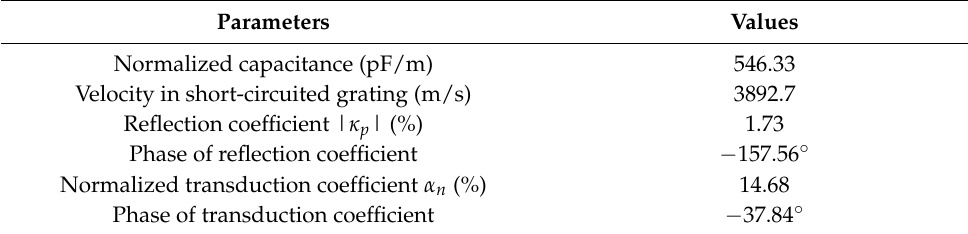
Table 2. COM parameters for EWC SPUDT on 128 ◦ YX LiNbO 3 for h = 0. Parameters